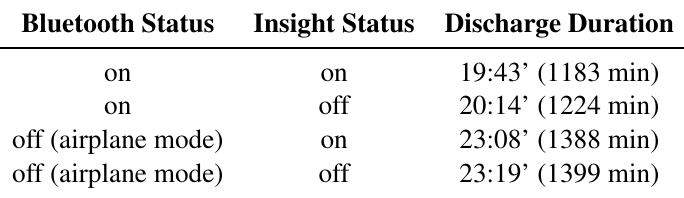
Table 3. Overall battery consumption of insight while running on the